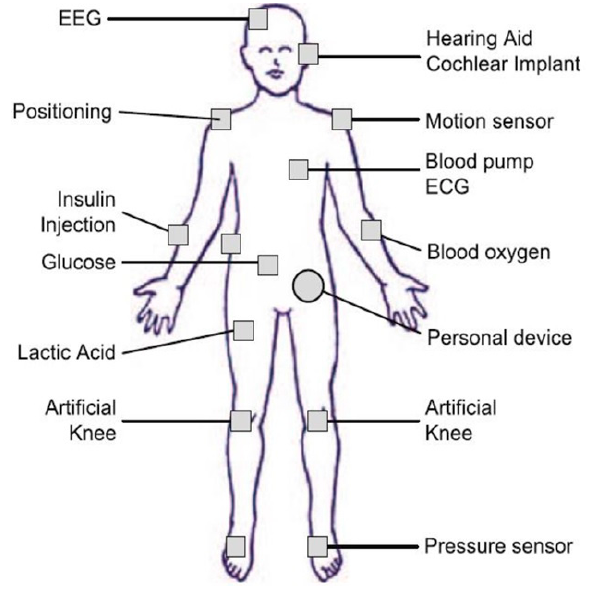
Figure 9. Patient monitoring [46].